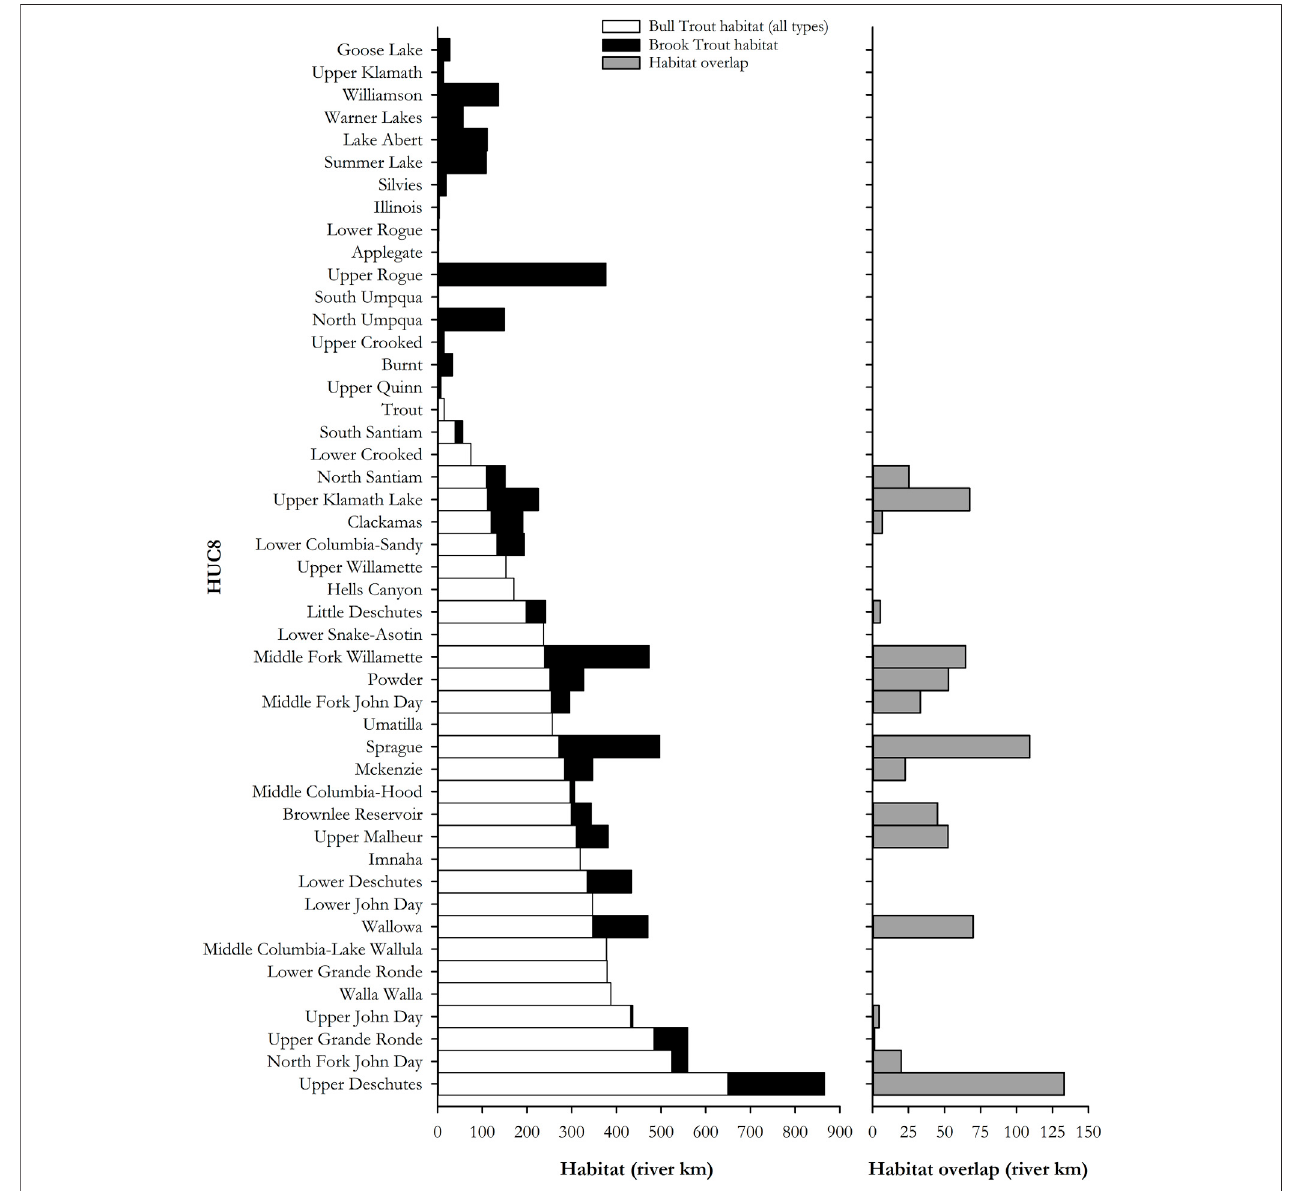
FIGURE 4 | Distribution in river kilometers, by HUC8, of bull/brook trout habitat in the study area in the left panel, with distribution overlap shown in the right panel.